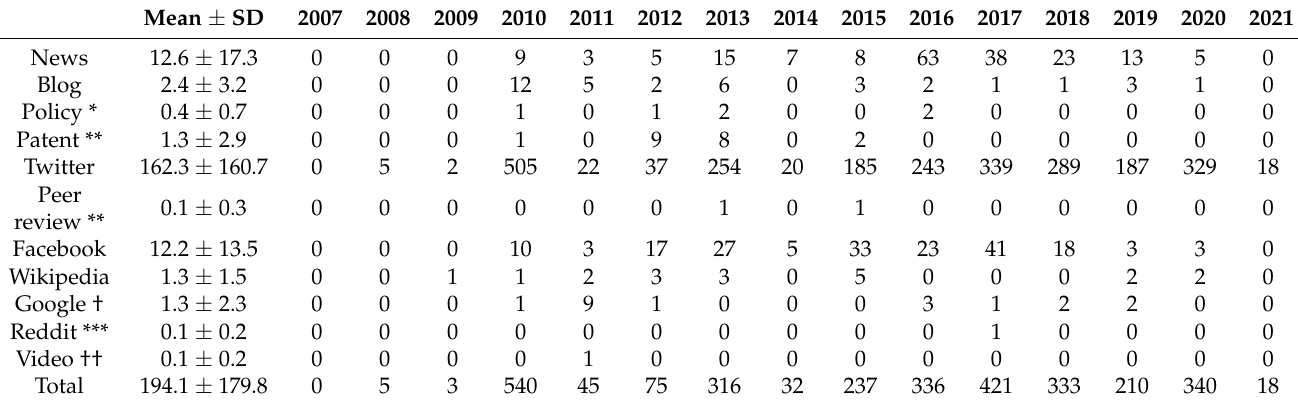
Table 1. Mean and standard deviation of mentions by source and total number of mentions that Altmetric Explorer tracked by sport and vision according to year.